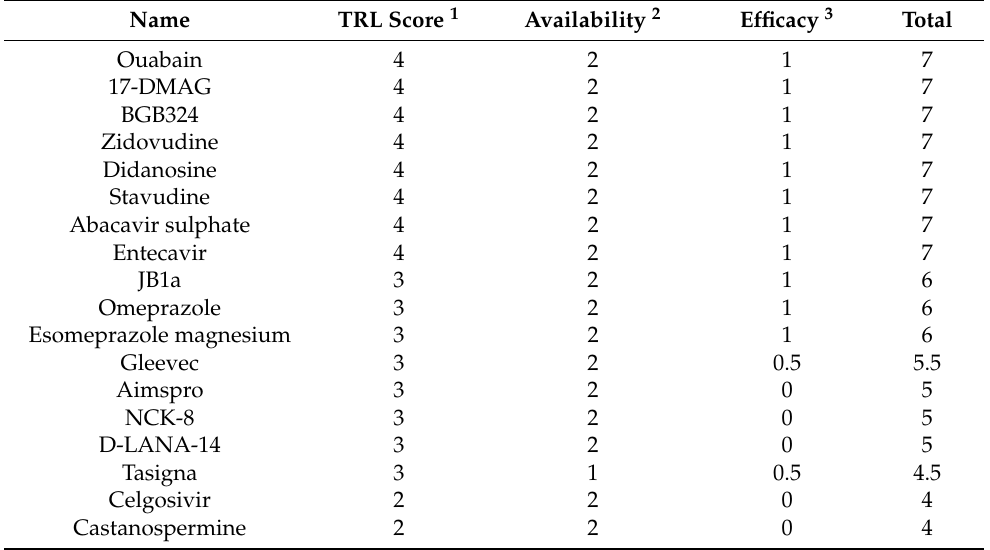
Table 1. Scoring of selected compounds for Ebola virus (EBOV) screening. TRL, Technical Readiness Level.